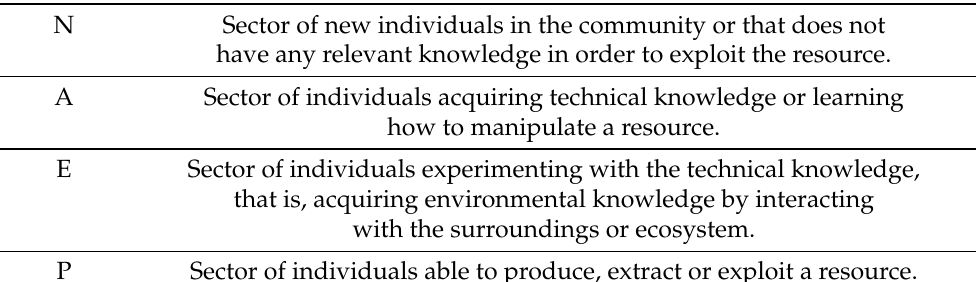
Table 1. Definitions of the sectors in which a community is structured. Own creation. N Sector of new individuals in the community or that does not have any relevant knowledge in order to exploit the resource. A Sector of individuals acquiring technical knowledge or learning how to manipulate a resource. E Sector of individuals experimenting with the technical knowledge, that is, acquiring environmental knowledge by interacting with the surroundings or ecosystem. P